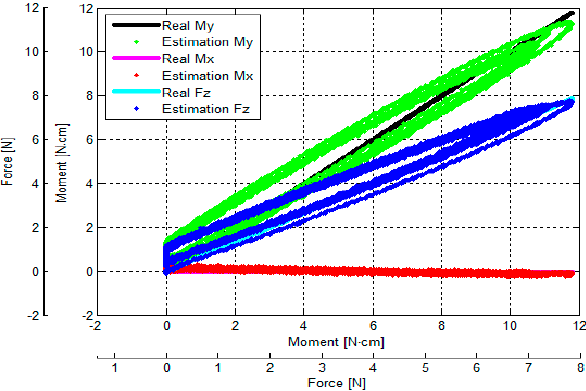
Figure 18. Comparison between real ( F z , M y ) values and estimated ( F z , M y ): external force was applied to and released from point ④ obtained by the sensor calibration device as shown in Figure 12.